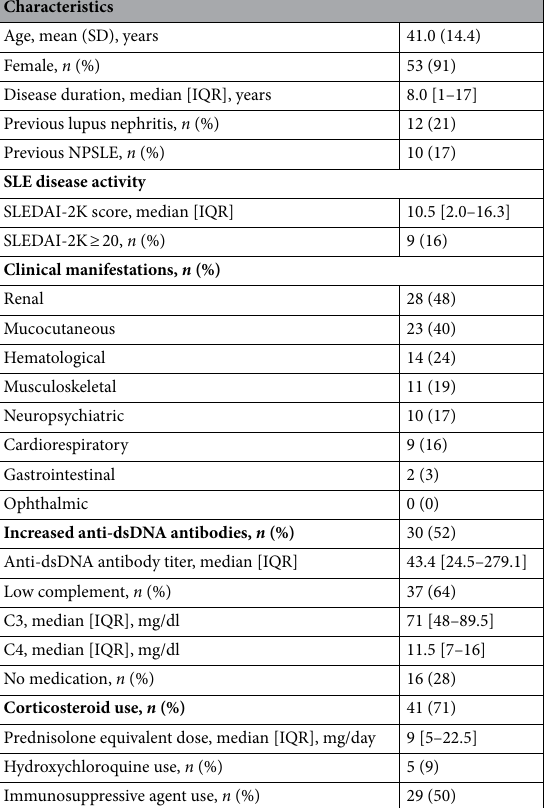
Table 1. Baseline characteristics of patients with SLE. SLE systemic lupus erythematosus, IQR interquartile range, NPSLE neuropsychiatric systemic lupus erythematosus, SLEDAI-2K systemic lupus erythematosus disease activity index in